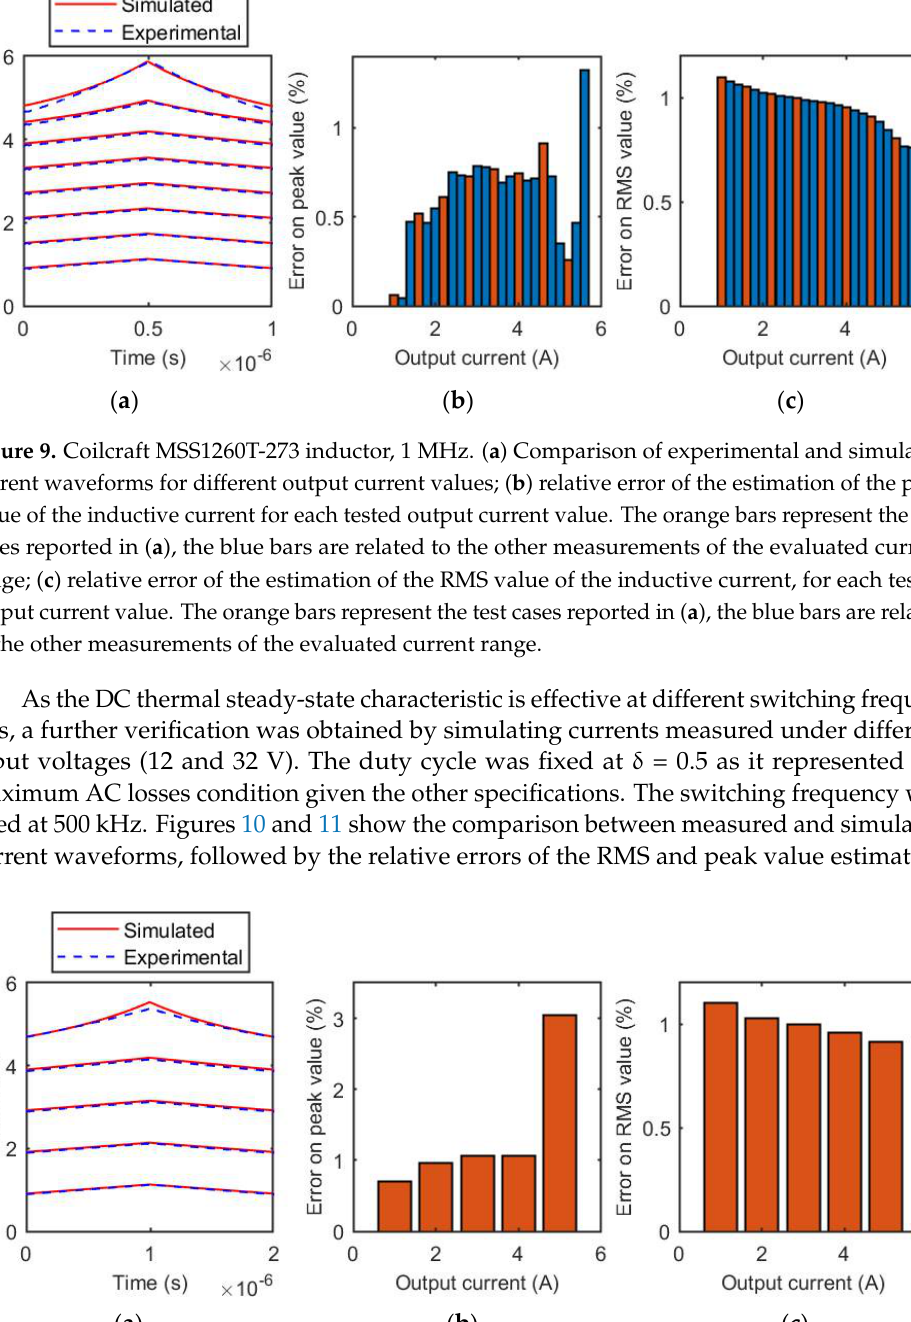
Figure 8. Coilcraft MSS1260T-273 inductor, 750 kHz. ( a ) Comparison of experimental and simulated current waveforms for different output current values; ( b ) relative error of the estimation of the peak value of the inductive current for each tested output current values. The orange bars represent the test cases reported in ( a ), the blue bars are related to the other measurements of the evaluated current range; ( c ) relative error of the estimation of the RMS value of the inductive current for each tested output current value. The orange bars represent the test cases reported in ( a ), the blue bars are related to the other measurements of the evaluated current range.